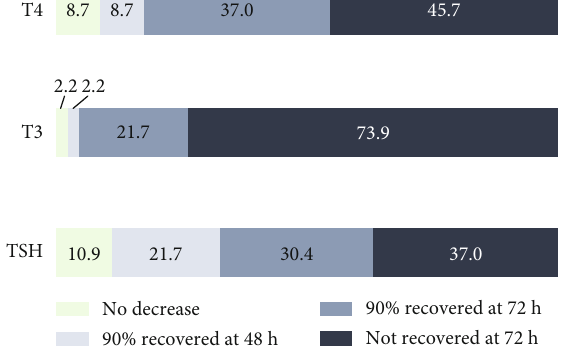
Figure 2: Time taken for the recovery of thyroid function tests following cardiac surgery among children. Among the participants, 10.9%, 2.2%, and 8.7% ( fi rst portion of the bars from the left) had no decrease in TSH, fT3, and fT4, respectively. Recovery rates are shown at 48 and 72 hours postop, as well as the percentage of participants who had no